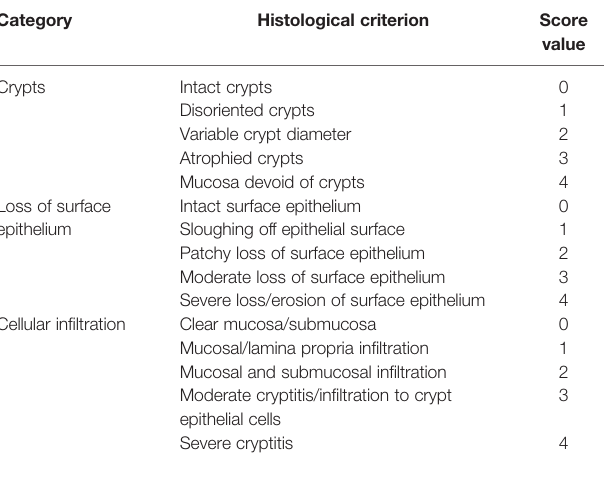
TABLE 1 | Colon histomorphology and neutrophil in fi ltration scoring criteria.